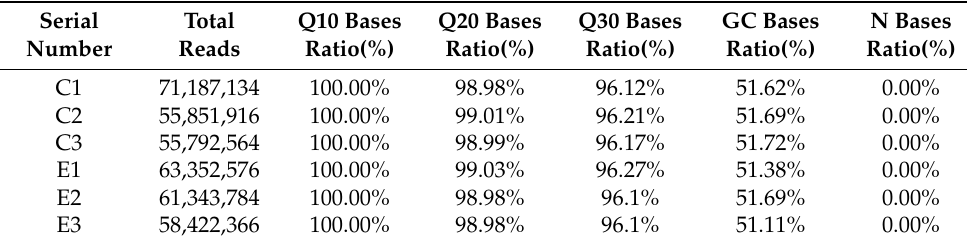
Table 5. Sequencing data statistical